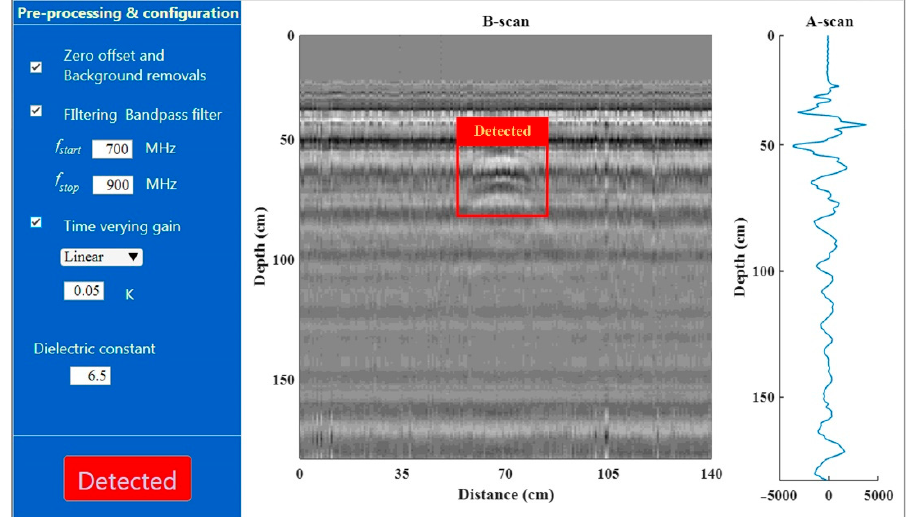
Figure 9. Software graphic user interface.